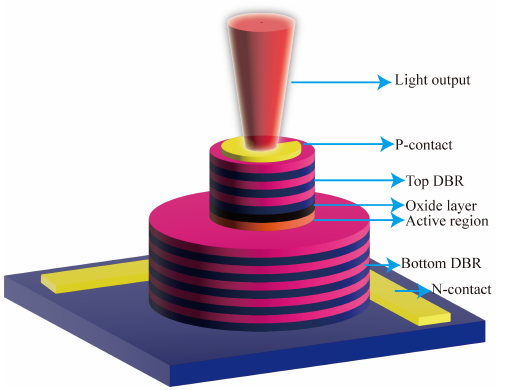
Figure 1. Structure of